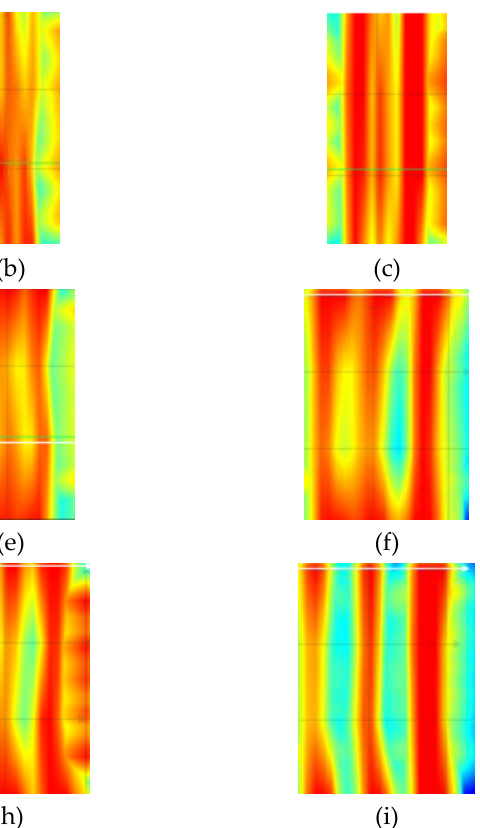
Figure 23. Results from tests performed with the radar equipment (3): ( a ) S-10-20 (result: one rebar, c obs = 11 mm), ( b ) S-10-30 (three rebars, c obs = 12 mm), ( c ) S-10-40 (three rebars, c obs = 11 mm), ( d ) S-16-20 (three rebars, c obs = 23 mm), ( e ) S-16-30 (three rebars, c obs = 24 mm), ( f ) S-16-40 (three rebars, c obs = 23 mm), ( g ) S-20-20 (two rebars, c obs = 38 mm), ( h ) S-20-30 (three rebars, c obs = 40 mm), ( i ) S-20-40 (three rebars, c obs = 41 mm)